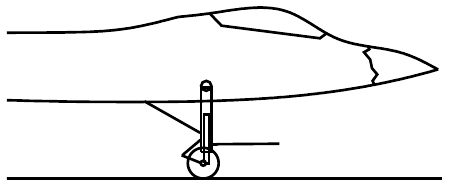
C14 B0 Figure 4. Connection relationships of the front landing structure of a carrier-based aircraft.